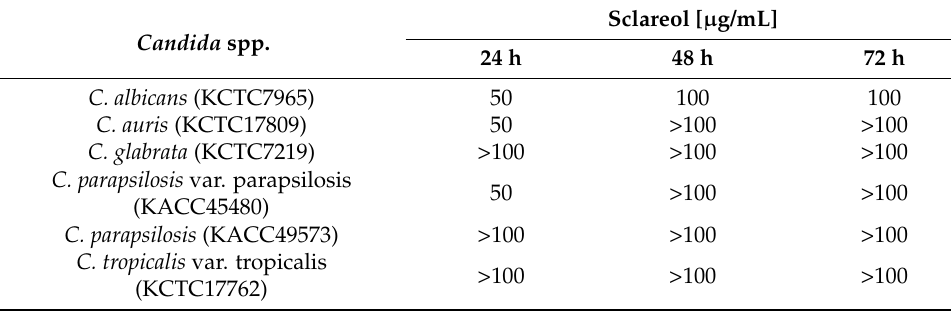
Table 2. Anti-fungal effects of Sclareol against Candida spp. Candida spp.